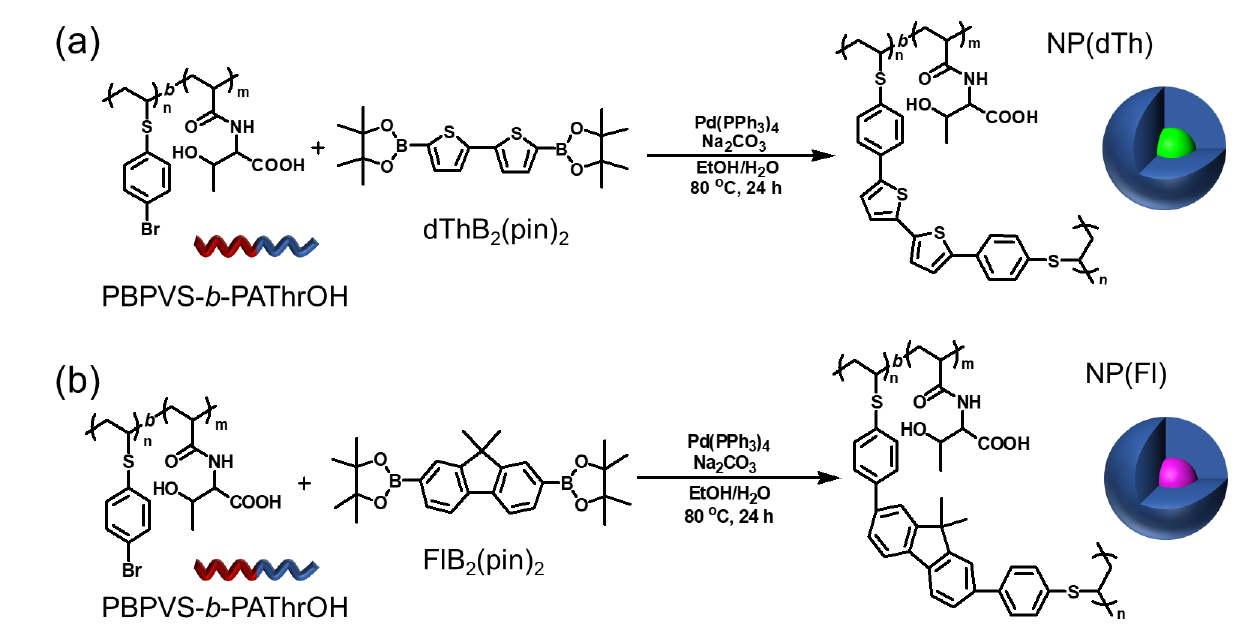
Scheme 1. Synthesis of the core-cross-linked fluorescent NPs with a threonine-based polyelectrolyte shell obtained via a one-pot coupling reaction: ( a ) NP(dTh) and ( b ) NP(Fl) using dithiophene (dTh)- and fluorene (Fl)-based diboronic acid esters,